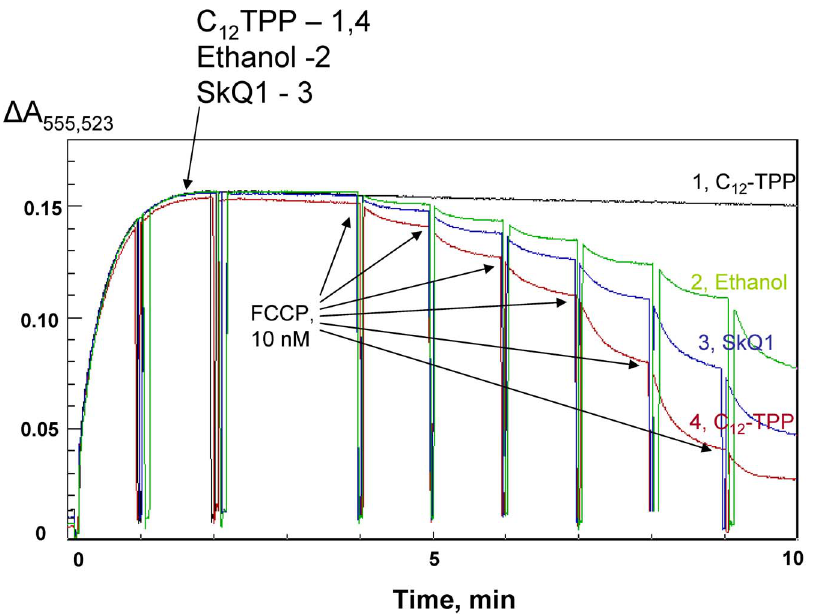
Figure 6. SkQ1 and C 12 TPP stimulate the uncoupling action of FCCP (carbonyl cyanide-p-trifluoromethoxyphenylhydrazone) in rat liver mitochondria. Mitochondrial potential was assayed by measuring the absorbance of safranin O. 10 nM FCCP was added at 4, 5, 6, 7, 8, and 9 min (curves 2–4). 0.2% ethanol or ethanol solutions leading to 2 m M C 12 TPP (curves 1 and 4) or 2 m M SkQ1 (curve 3) were added at 2 min. Oligomycin (1 m g/ml) was added at 1 min. For other conditions, see Materials and methods.